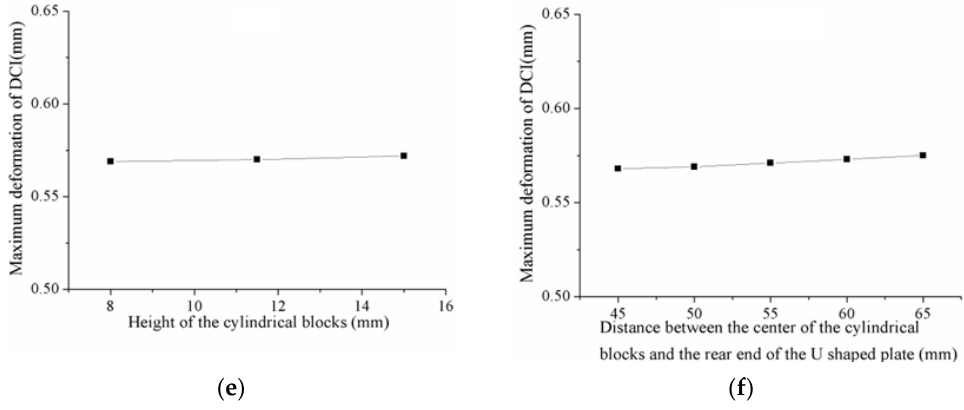
Figure 4. Influence of the geometric sizes and position of the blocks on the DCI’s maximum deformation: ( a ) the length of the cuboid block; ( b ) the width of the cuboid block; ( c ) the height of the cuboid block; ( d ) the radius of the cylindrical blocks; ( e ) the height of the cylindrical blocks; ( f ) the distance between the center of the cylindrical blocks and the rear end of the U-plate, assuming other factors being equal.